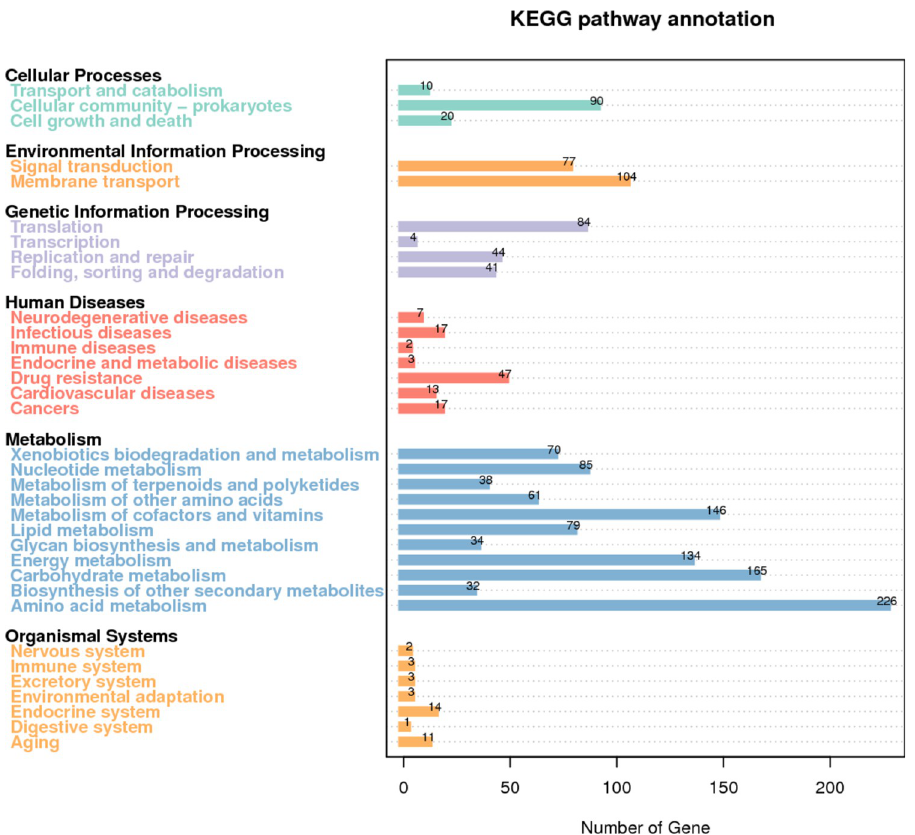
Fig 3. KEGG annotation of VJR422. The horizontal axis is KEGG pathway type, and the vertical axis is the number of annotated genes.